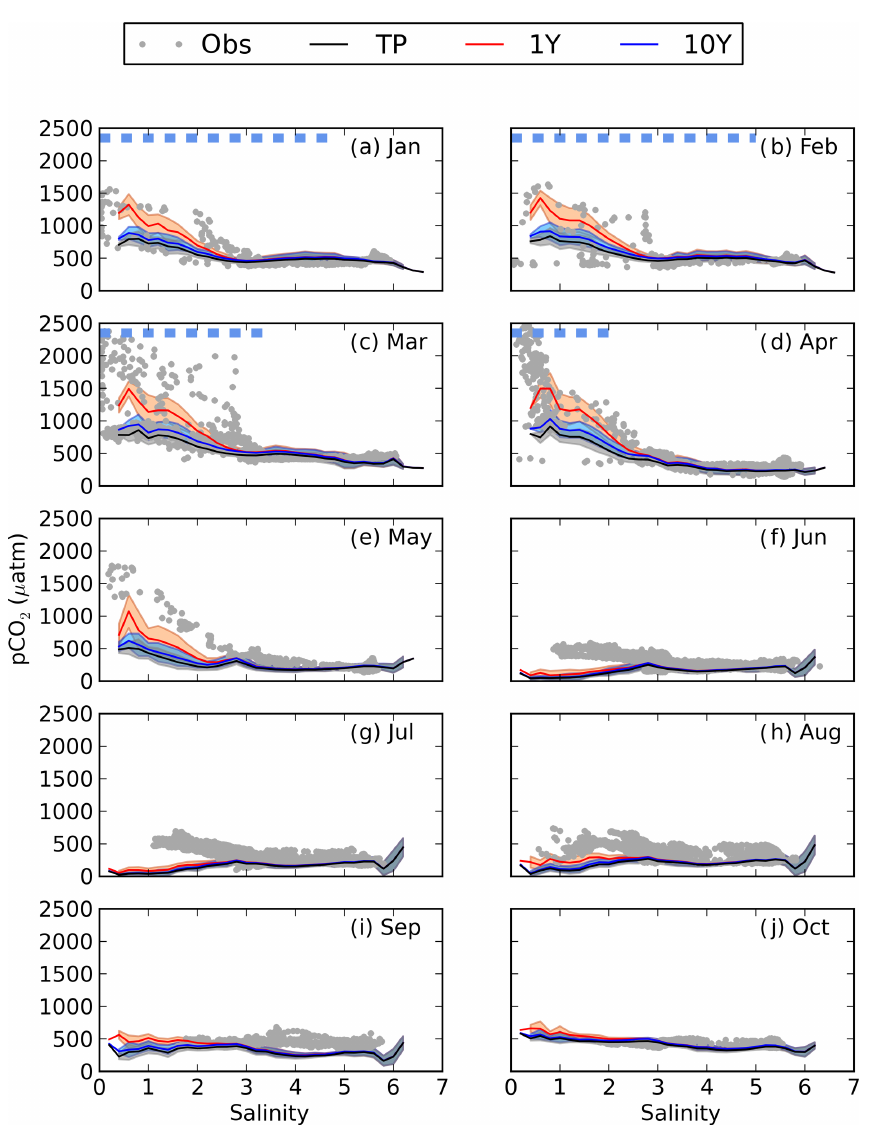
Figure 5. p CO 2 –salinity relationships for January–October ( a–j ). Grey dots show observed values. The black, red and blue lines show modelled climatological monthly means for the TP, 1Y and 10Y experiments, with the shaded area displaying the standard deviation at a given salinity. The dashed blue line shows the ice extent (salinities at which the ice concentration is larger than